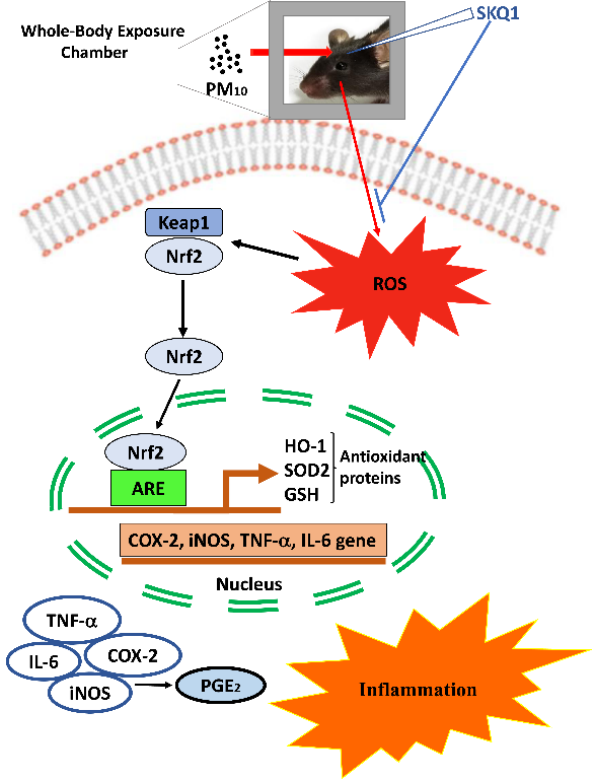
Figure 7. Whole body exposure to PM 10 is shown diagrammatically.